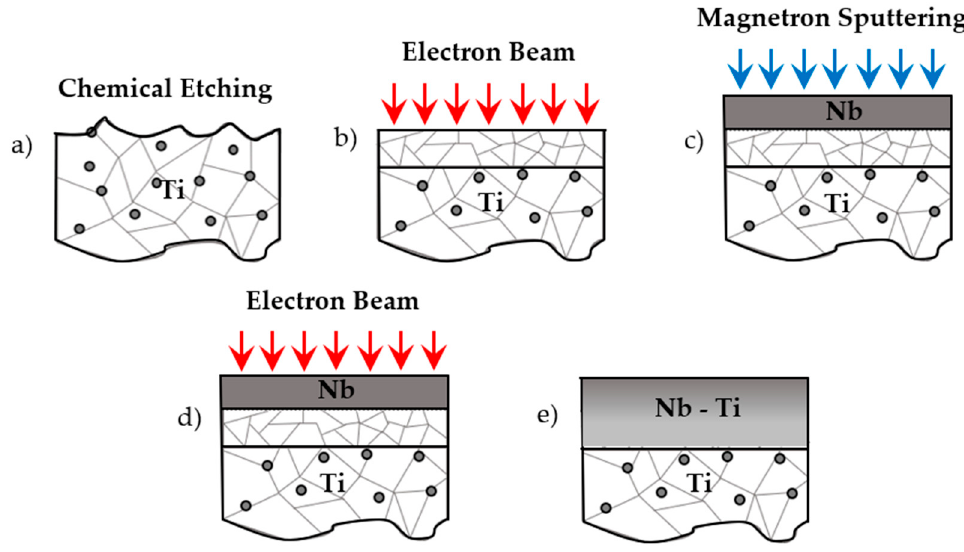
Figure 1. Scheme of the treatment cycle ( a – e ).